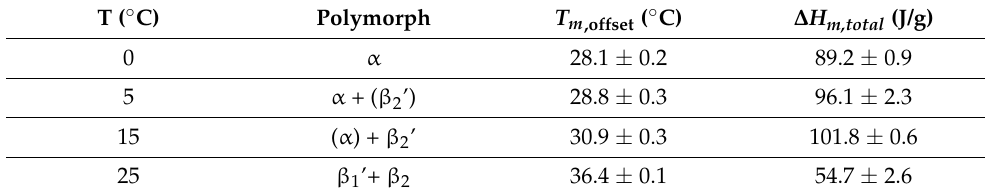
Figure 2. Melting profiles (endo down) of non-tempered ( A ) and tempered ( B ) cocoa butter kept isothermally at 0, 5, 15 or 25 ◦ C. Table 4. The offset temperature of melting and total melting enthalpy of non-tempered cocoa butter kept at several temperatures, determined via DSC (Differential Scanning Calorimetry). The polymorphic type was obtained from